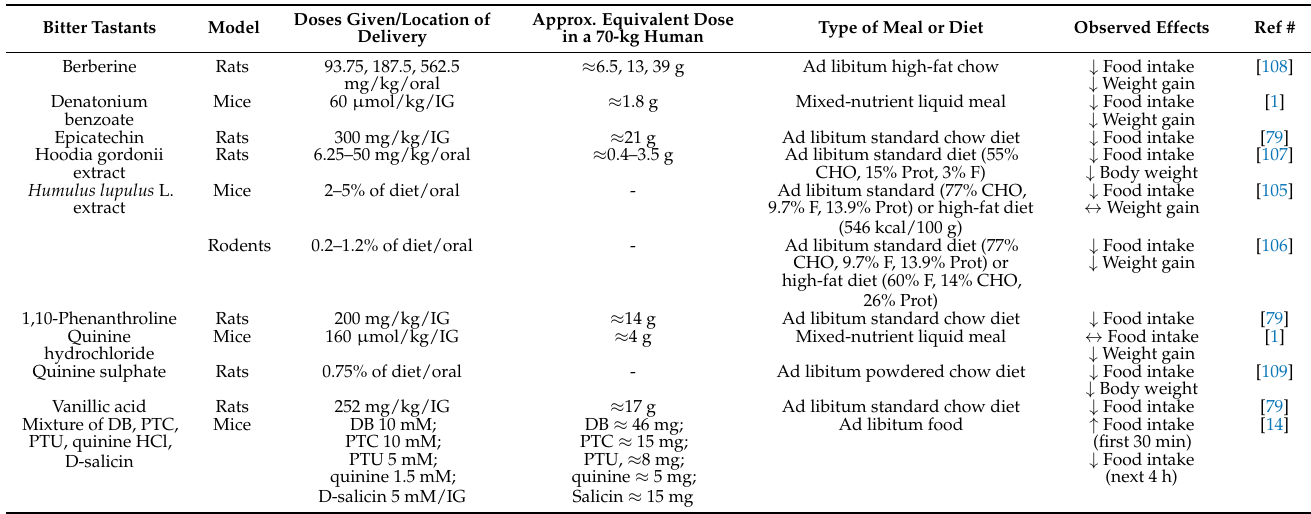
Table 5. Effects of bitter substances on food intake and body weight in preclinical